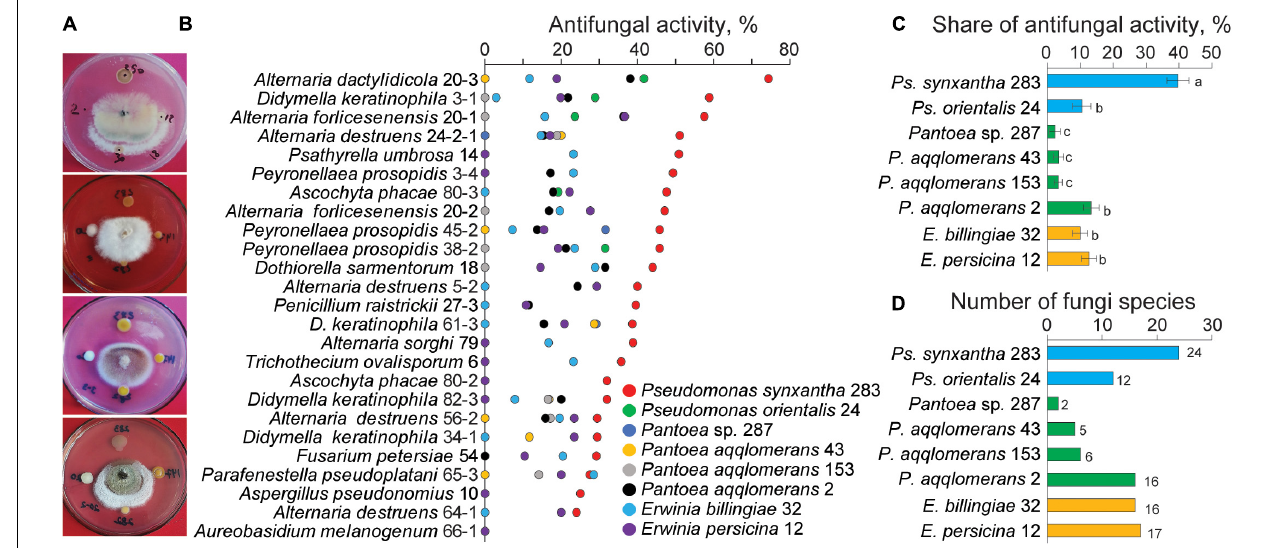
FIGURE 4 | Antifungal activity of the gut bacteria against different fungal species isolated from wild apple twigs. (A) Examples of the gut bacterial inhibition of wild apple fungi. (B) Antifungal activity of the gut bacteria against selected fungi from the different types of apple twigs. (C) Share of antifungal activity of each gut bacteria. Different letters indicate significant differences determined by one-way ANOVA, followed by a Fisher PLSD post-hoc test ( p < 0.05). (D) Number of fungal isolates inhibited by each gut